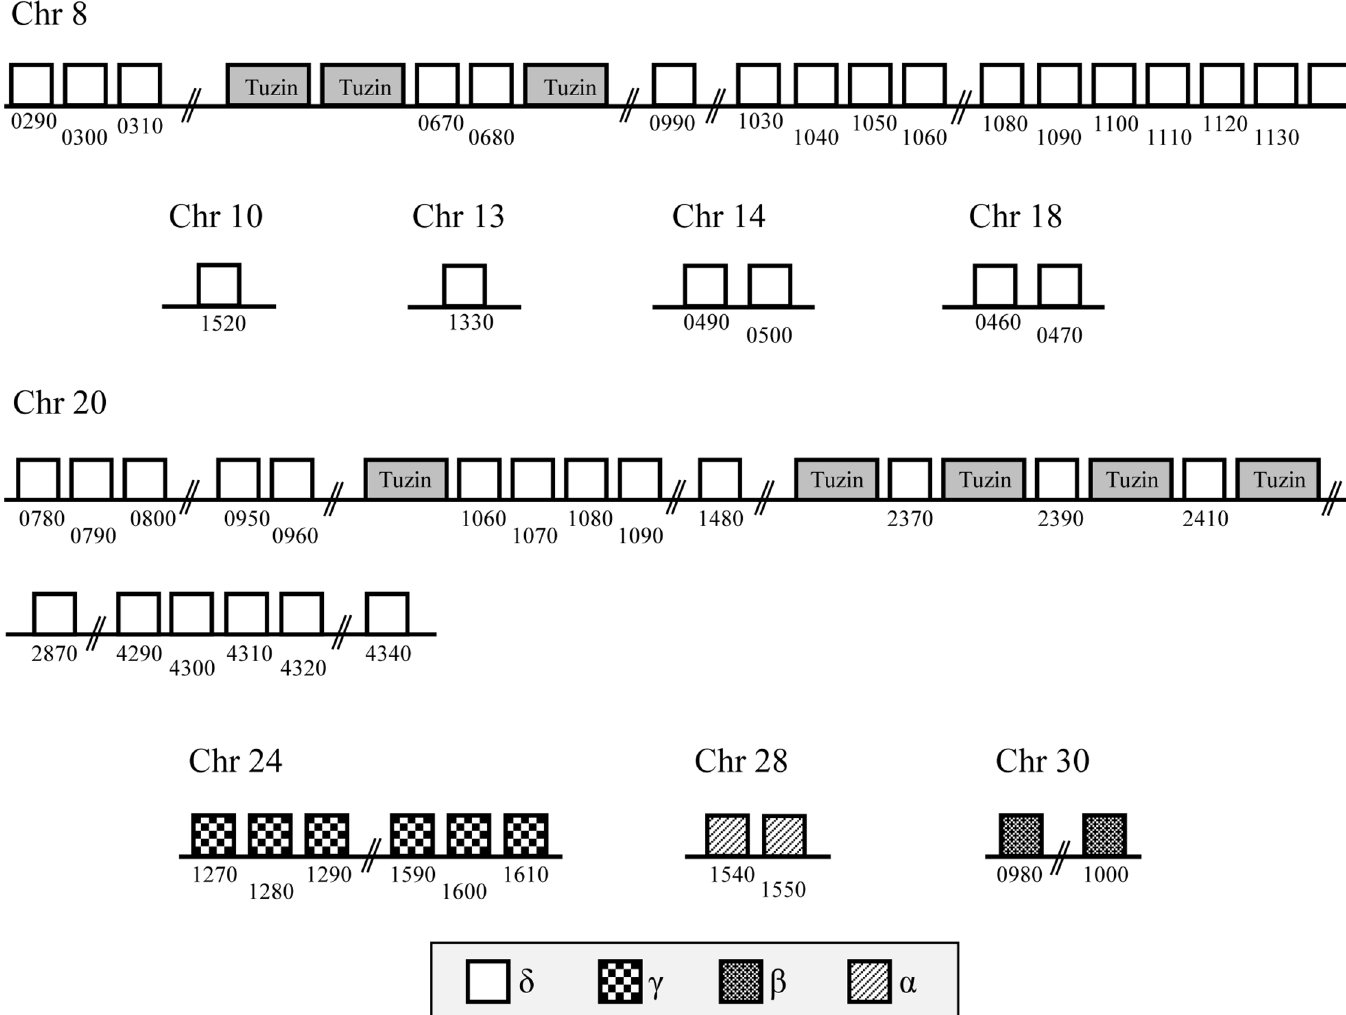
Fig 1. Genomic organization of the amastin genes in L . braziliensis . The schematic representation of 52 amastin gene copies located on nine different chromosomes was based on the complete genome sequence of L . braziliensis MHOM/BR/75/M2904 obtained from the Tritryp database (www.tritrypdb.org). The numbers below the boxes correspond to the given names of each amastin L . braziliensis gene homolog in GeneDB. Boxes with the same background correspond to amastin gene copies belonging to the same subfamily. Eight tuzin genes, shown as gray boxes, are associated only with δ